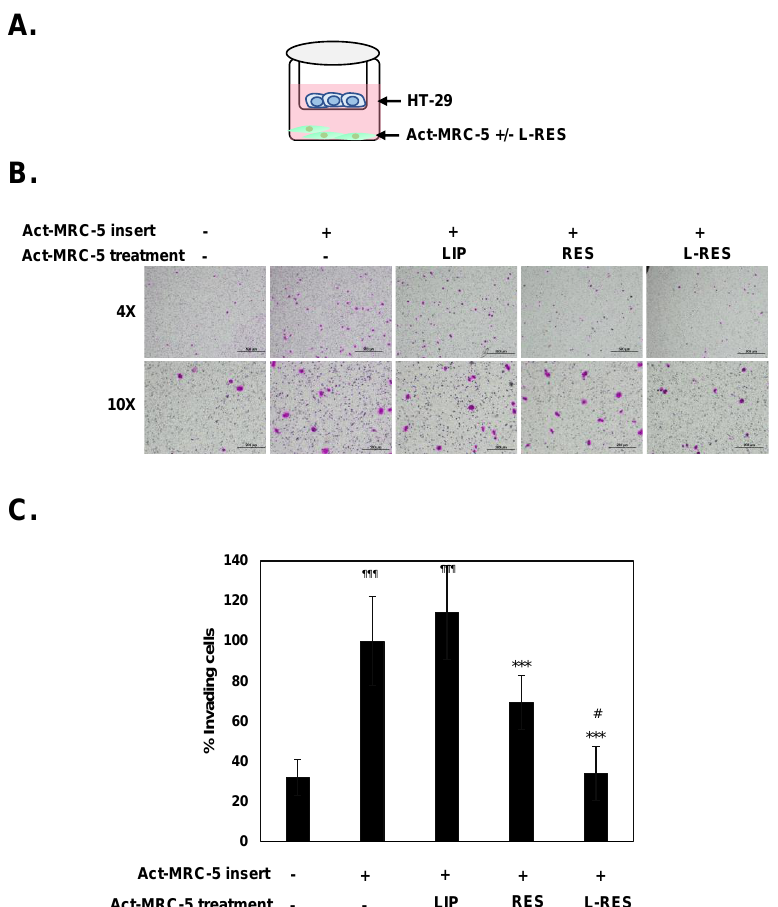
Figure 5. L-RES treatments diminish the activated fibroblasts promote cancer cell invasion. The HT-29 cells were co-cultured with the activated fibroblast; Act-MRC-5, which was treated with RES; LIP; or L-RES. Cell migration or cell invasion was determined using Boyden chamber assay for 24 h. ( A ) Co-culture between HT-29 and Act-MRC-5 with treatments. ( B ) The invaded cells were captured using an inverted microscope with five fields/well, in triplicated well at 10× magnification. ( C ) Percentages of invaded cells were presented (untreated Act-MRC-5 control cells = 100%). The data are means ± SD from the representative experiments. *** p < 0.05 vs. Act-MRC-5 control. ¶¶¶ p < 0.001 vs. MRC-5 control. # p < 0.05 vs. free